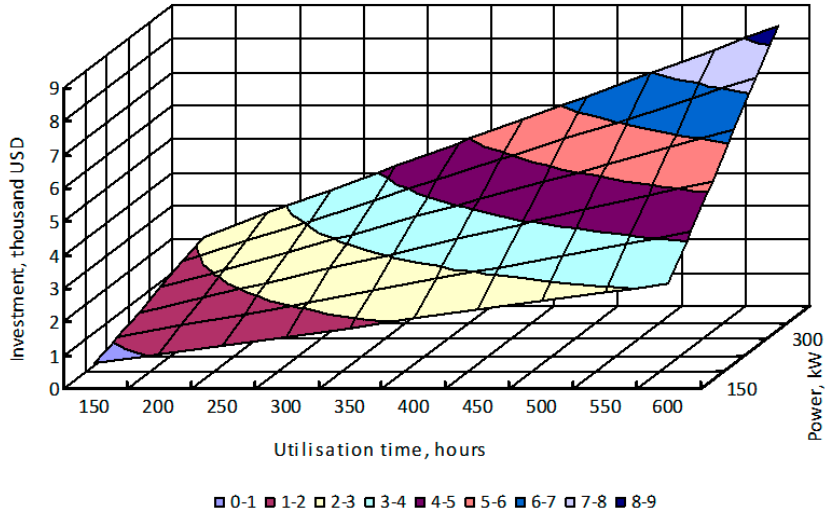
Figure 8. Maximum electric turbocompounding system cost (simple payback period—3 years).